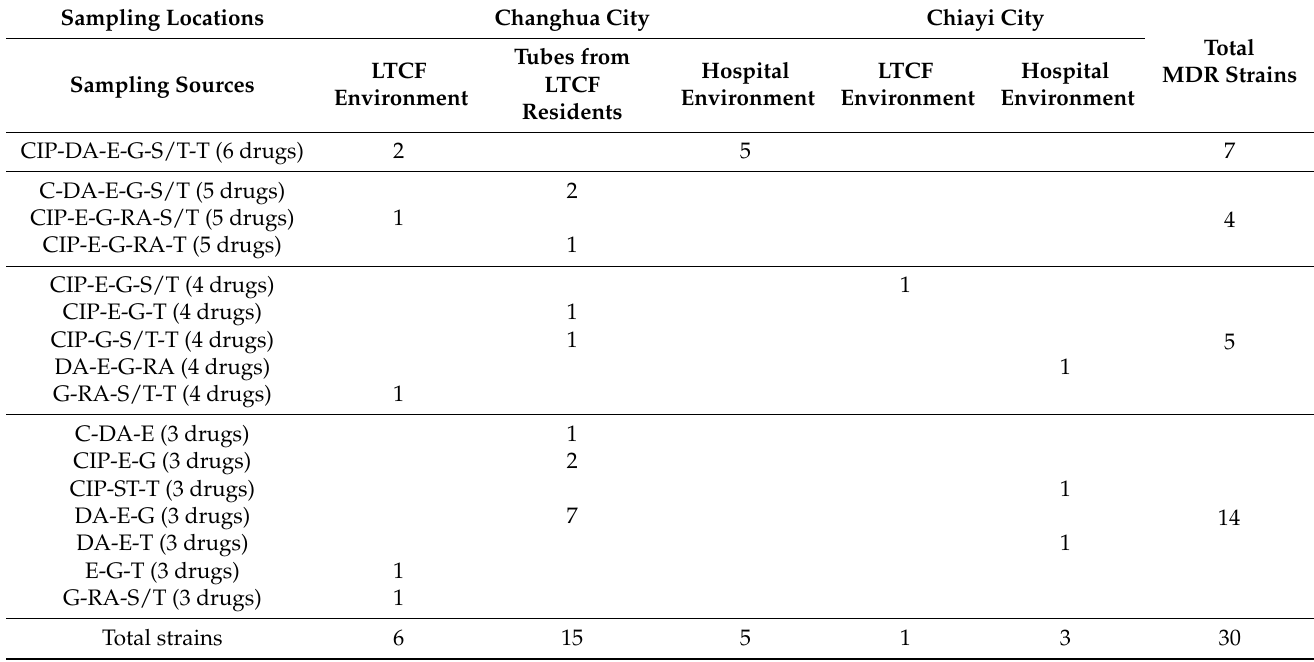
Table 5. MDR pattern profile results of 30 MRSA